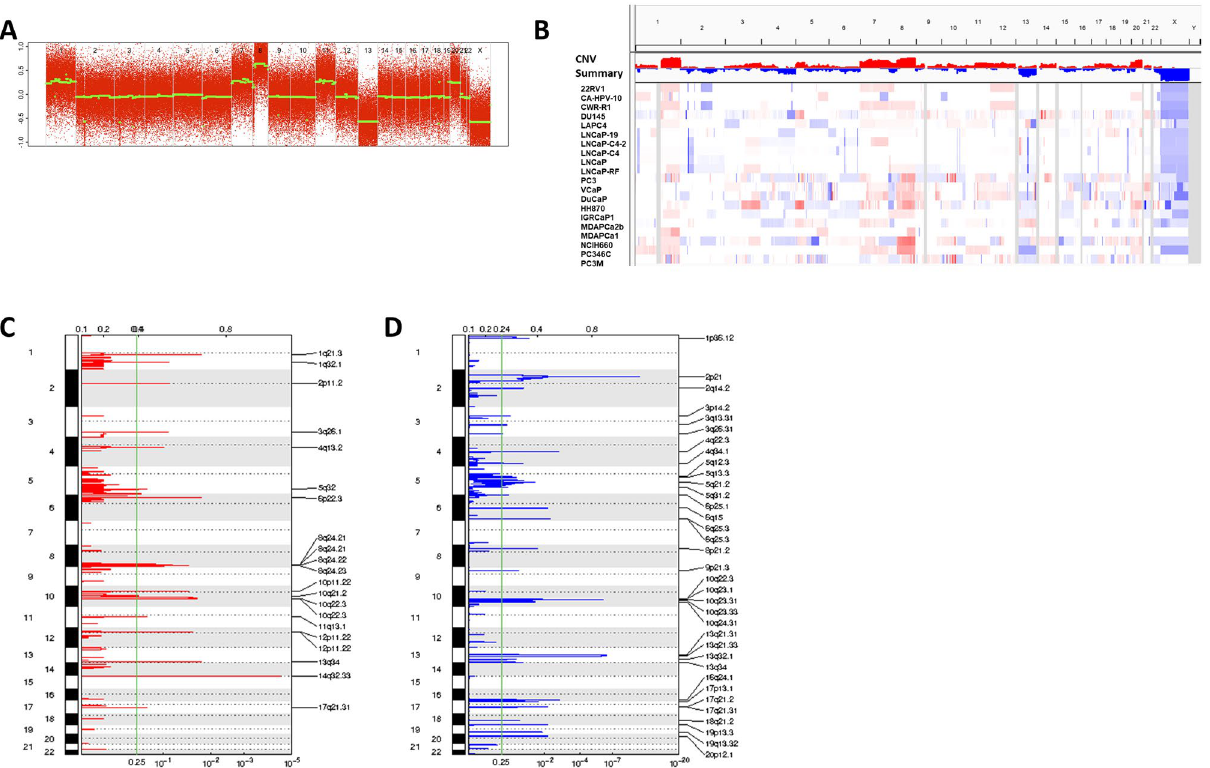
Figure 2. Copy number analysis of prostate cancer cell lines. ( A ) Example of ASCAT copy number estimates (green line) for the prostate cancer cell line PC346C demonstrating regions of gain and loss. ( B ) IGV view of copy number changes in individual cell lines and the average copy number changes in the entire cell line panel. ( C, D ) GISTIC analysis of recurrent regions of copy number gain ( C ) and loss ( D ). Many of the recurrent regions of copy number alterations observed in the cell lines are the same as those seen in prostate cancer specimens as defined by the